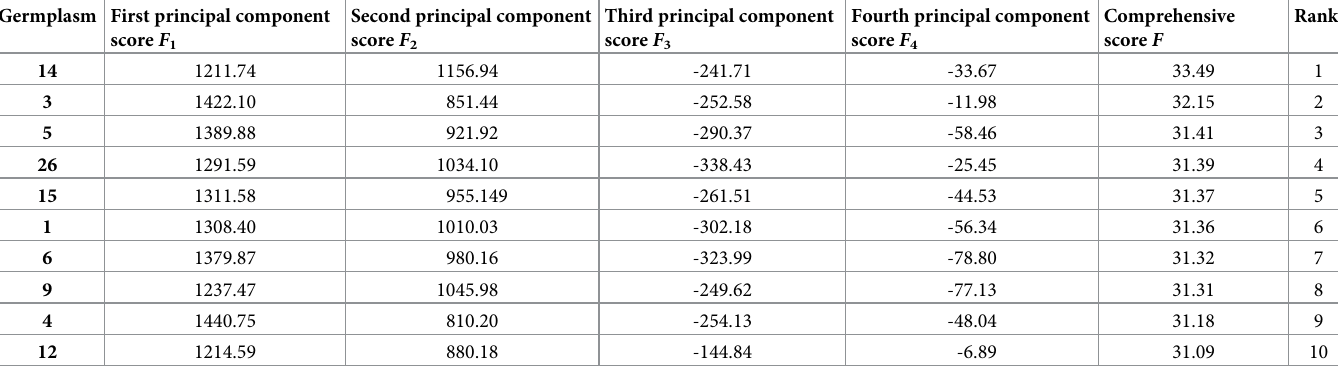
Table 2. Comprehensive scores of top ten high-oleic rape germplasms.